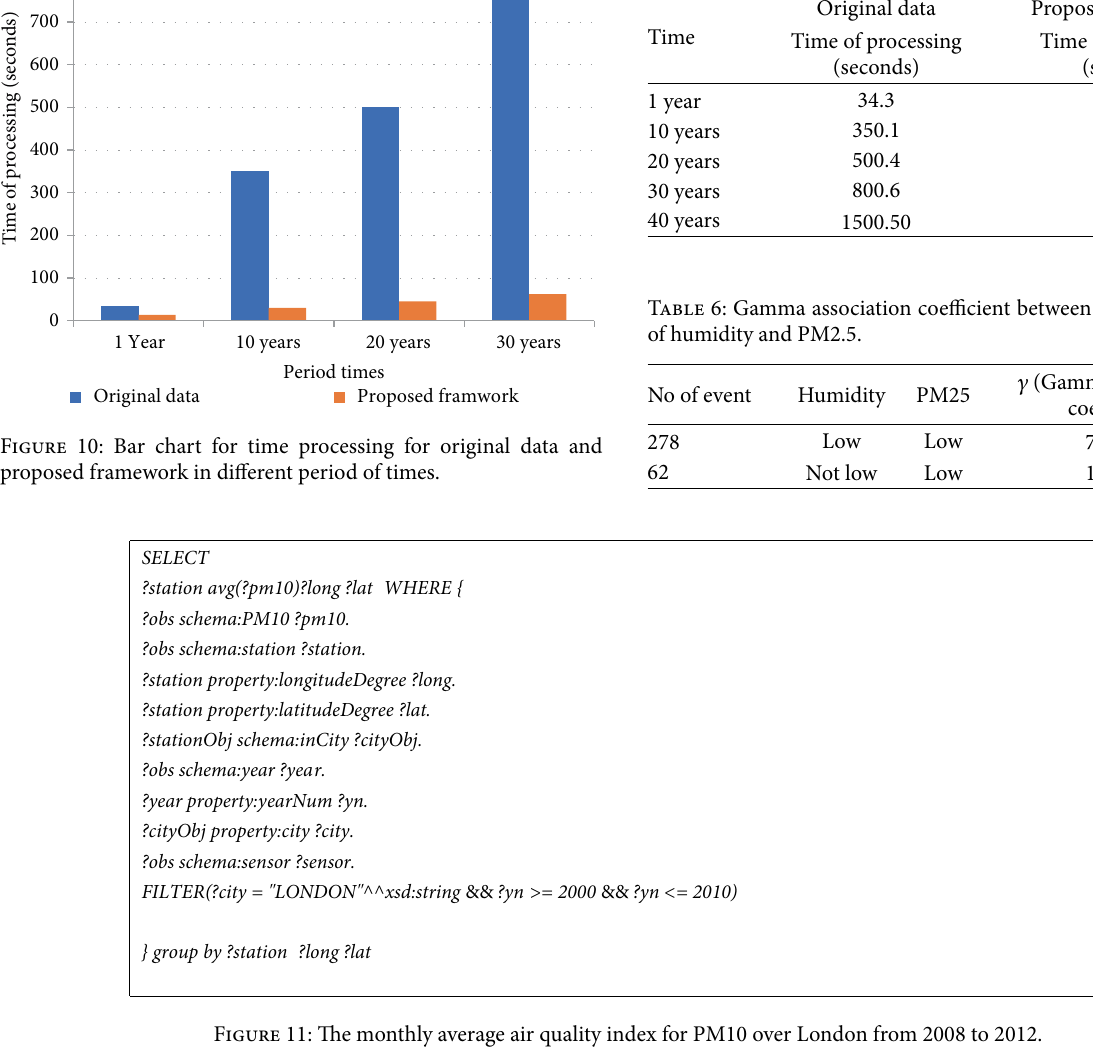
Figure 11: The monthly average air quality index for PM10 over London from 2008 to 2012.